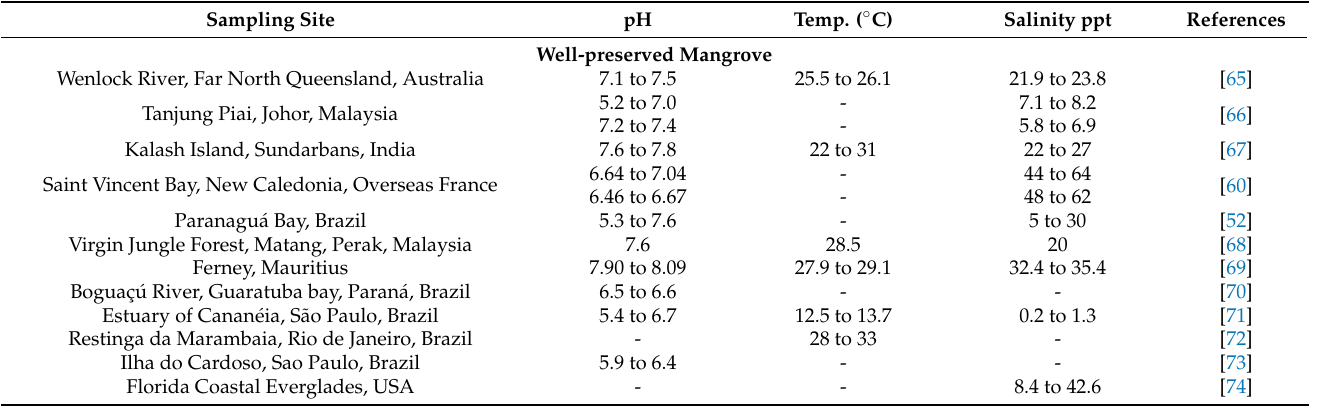
Table 2. Levels of pH, temperature, and salinity of well-preserved, restored and disturbed mangrove soil. Sampling